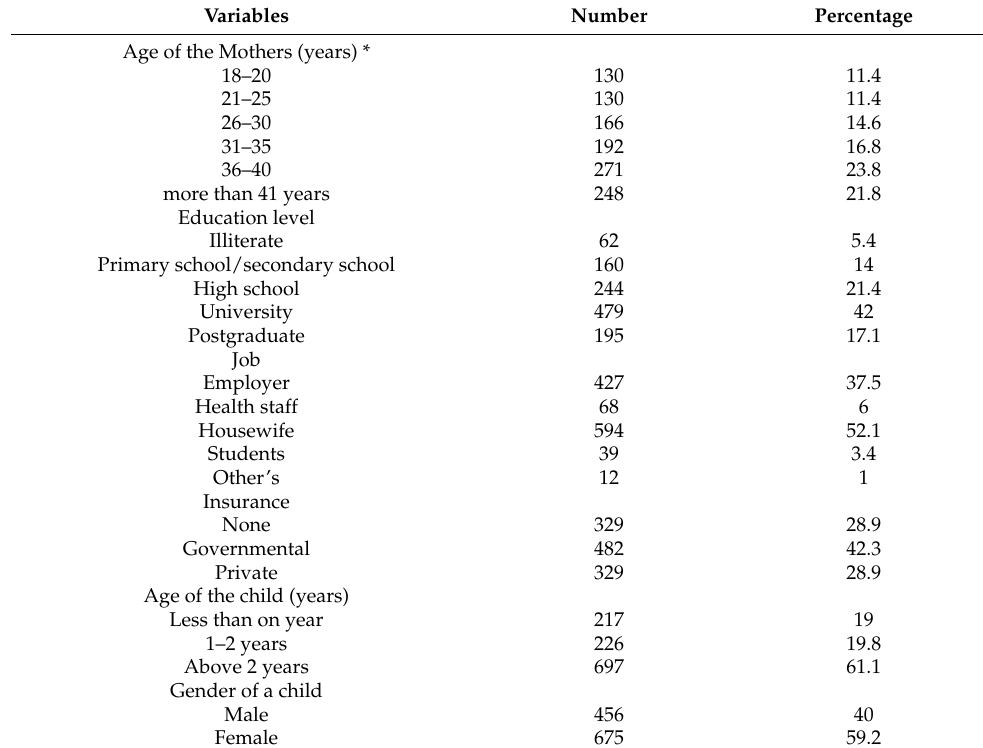
Table 1. Demographic data of mothers and their